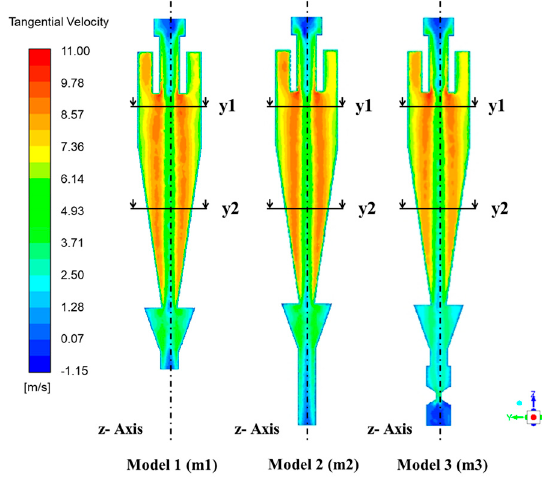
Figure 8. Contour of tangential velocity for each cyclone model.